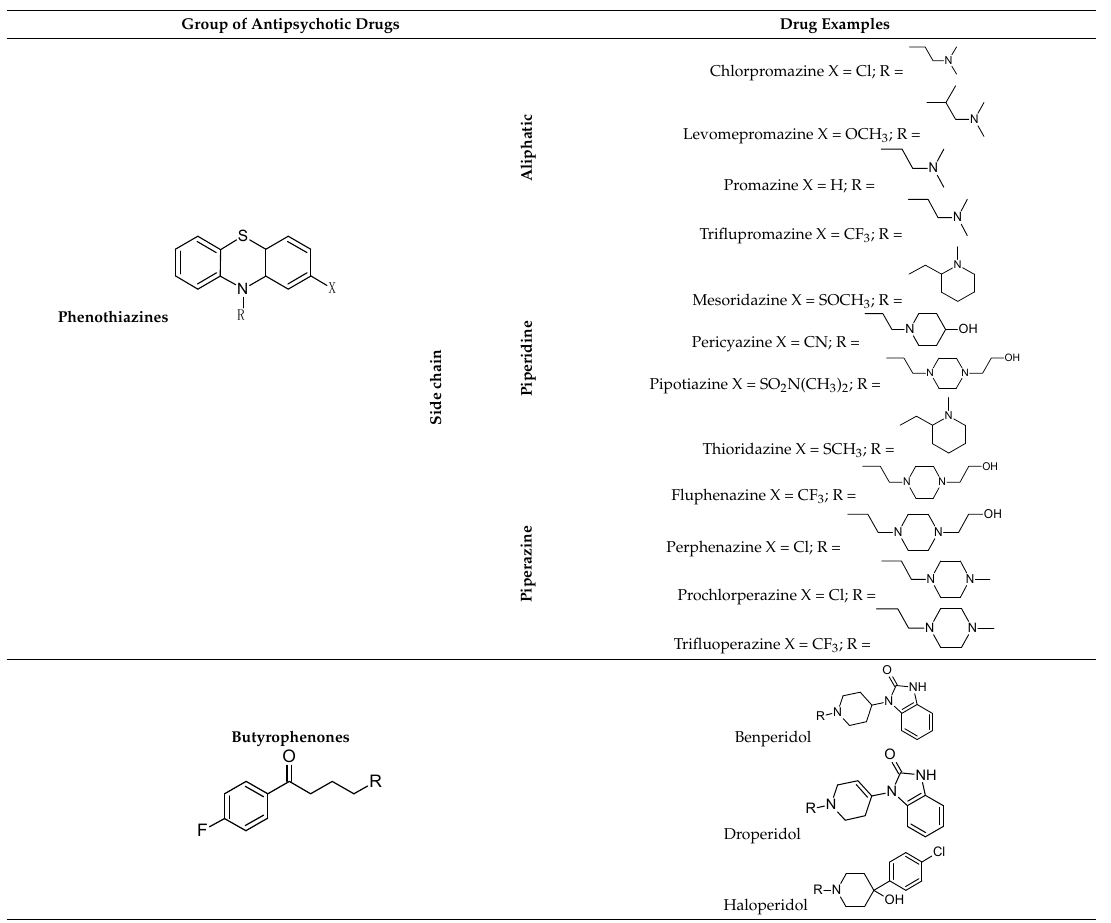
Table 1. Classification of first-generation antipsychotic drugs: examples and their chemical structures.